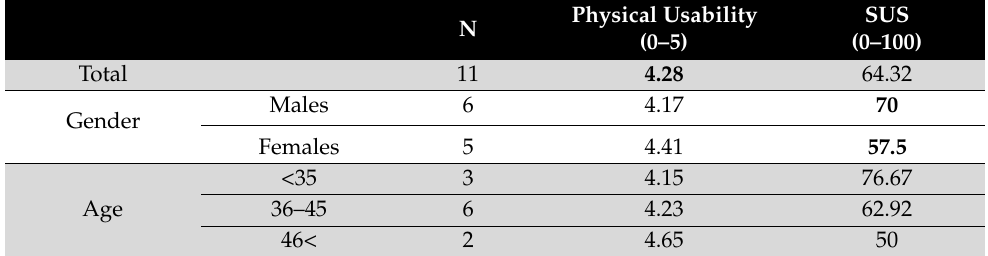
Figure 13. Evaluating the aesthetic perception of the system. Table 3. Summary of the system usability scale (SUS) and designated usability questionnaire.